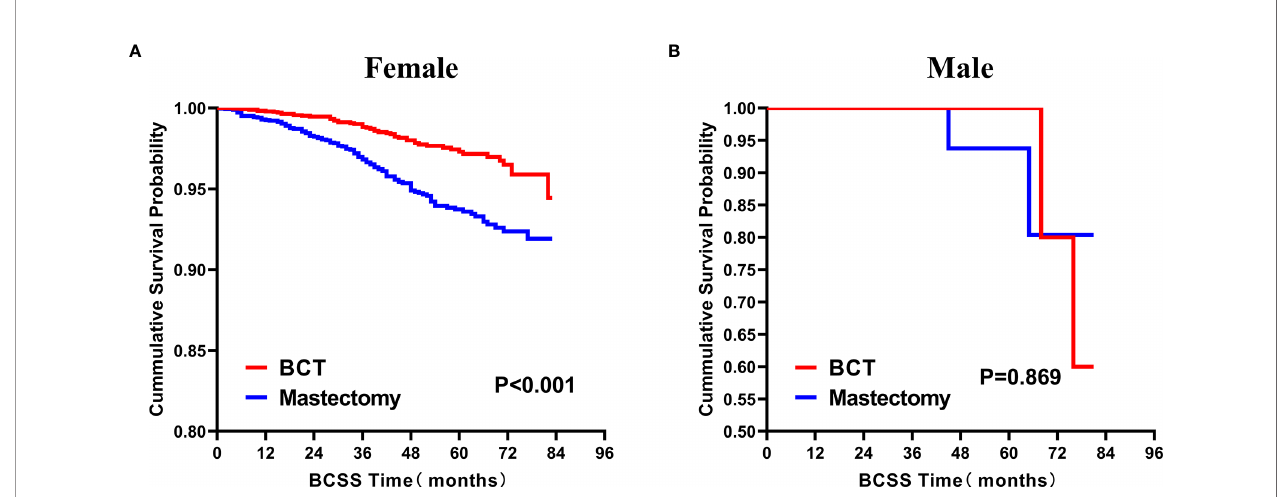
FIGURE 4 | Kaplan – Meier Curves for BCSS by treatment type for all patients, strati fi ed by sex: (A) Female. (B) Male. BCSS, breast cancer speci fi c survival; BCT, breast-conserving therapy.